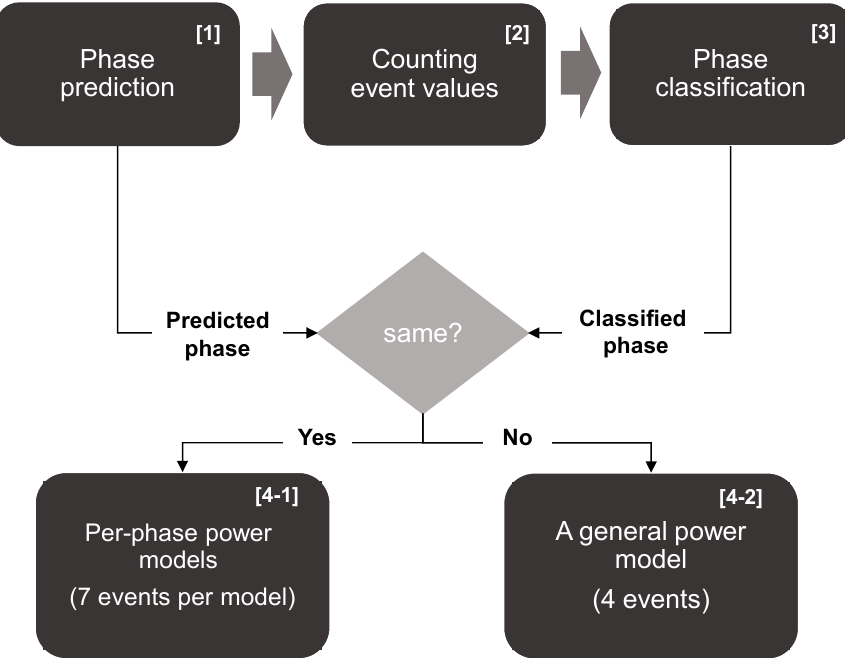
Figure 3. Overall process of the proposed CPU power model.